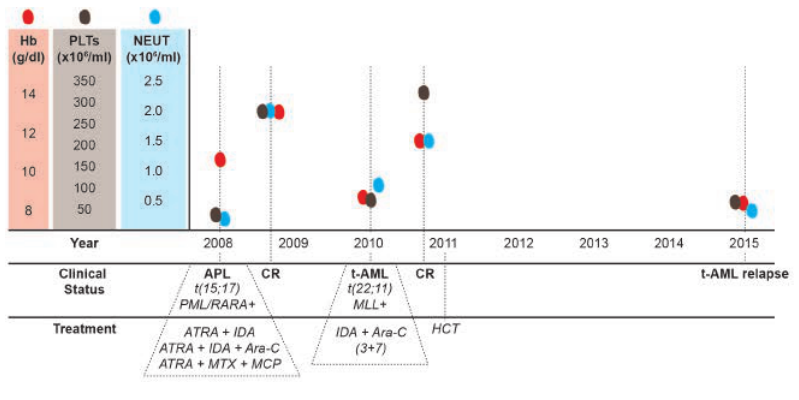
Figure 1. Schematic representation of the evolution of the reported case. The X-axis depicts time (year). The upper part of the scheme shows hemoglobin levels (Hb, red dots and corresponding Y-axis within red-shaded block), platelet counts (PLTs, brown dots and corresponding Y-axis within brown-shaded block) and neutrophil counts (NEUT, blue dots and corresponding Y-axis within blue-shaded block) as measured at the indicat- ed times (vertical dashed lines). In the lower part of the scheme, the clinical status and treatment given at the indicated times (vertical dashed lines) is highlighted. APL: acute promyelocytic leukemia; t-AML: therapy related acute myeloid leukemia; CR: complete remission; HCT: allogenic hematopoietic cell transplantation.